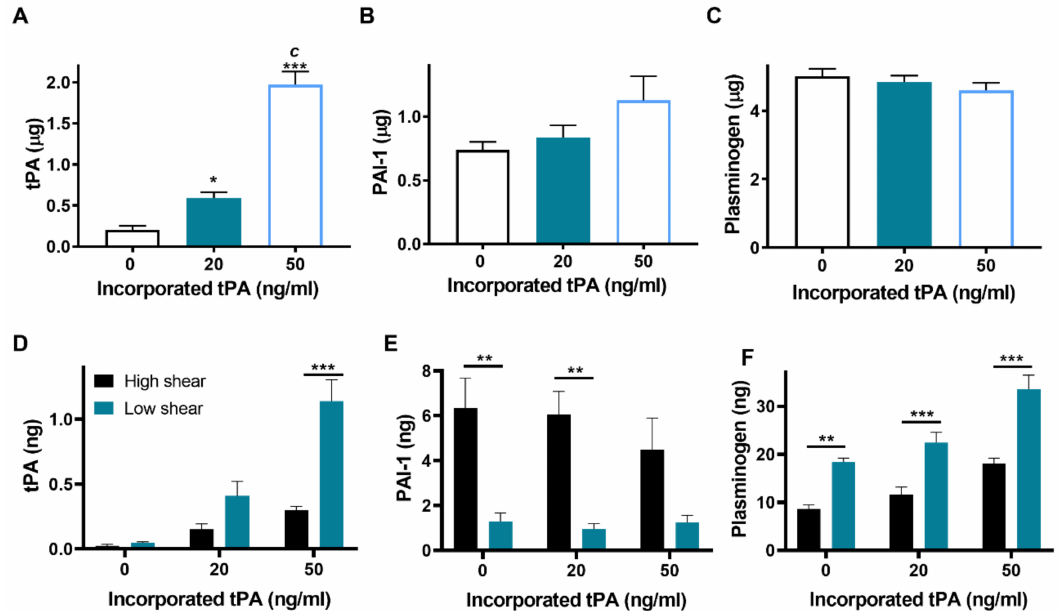
Figure 5. Thrombi formed at low shear have higher levels of tPA and plasminogen. Whole blood thrombi were formed in Badimon chambers on a thrombogenic surface under low (212 s − 1 ) and high (1690 s − 1 ) shear rates. Levels of tPA, PAI-1 and plasminogen antigen were measured by ELISA in the effluent ( A – C , respectively), * p < 0.05, *** p < 0.001 vs. no tPA, c p < 0.001 vs. 20 ng/mL tPA and the thrombus bathing fluid ( D – F , respectively), ** p < 0.01, *** p < 0.001 vs high shear. Data shown are mean ± SEM ( n =